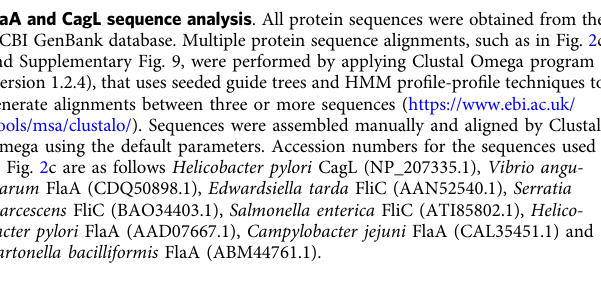
Fig. 5 Models for TLR5-mediated and CagL-dependent H. pylori pathogenesis. a TLR5 is not expressed in healthy gastric tissue. H. pylori infection